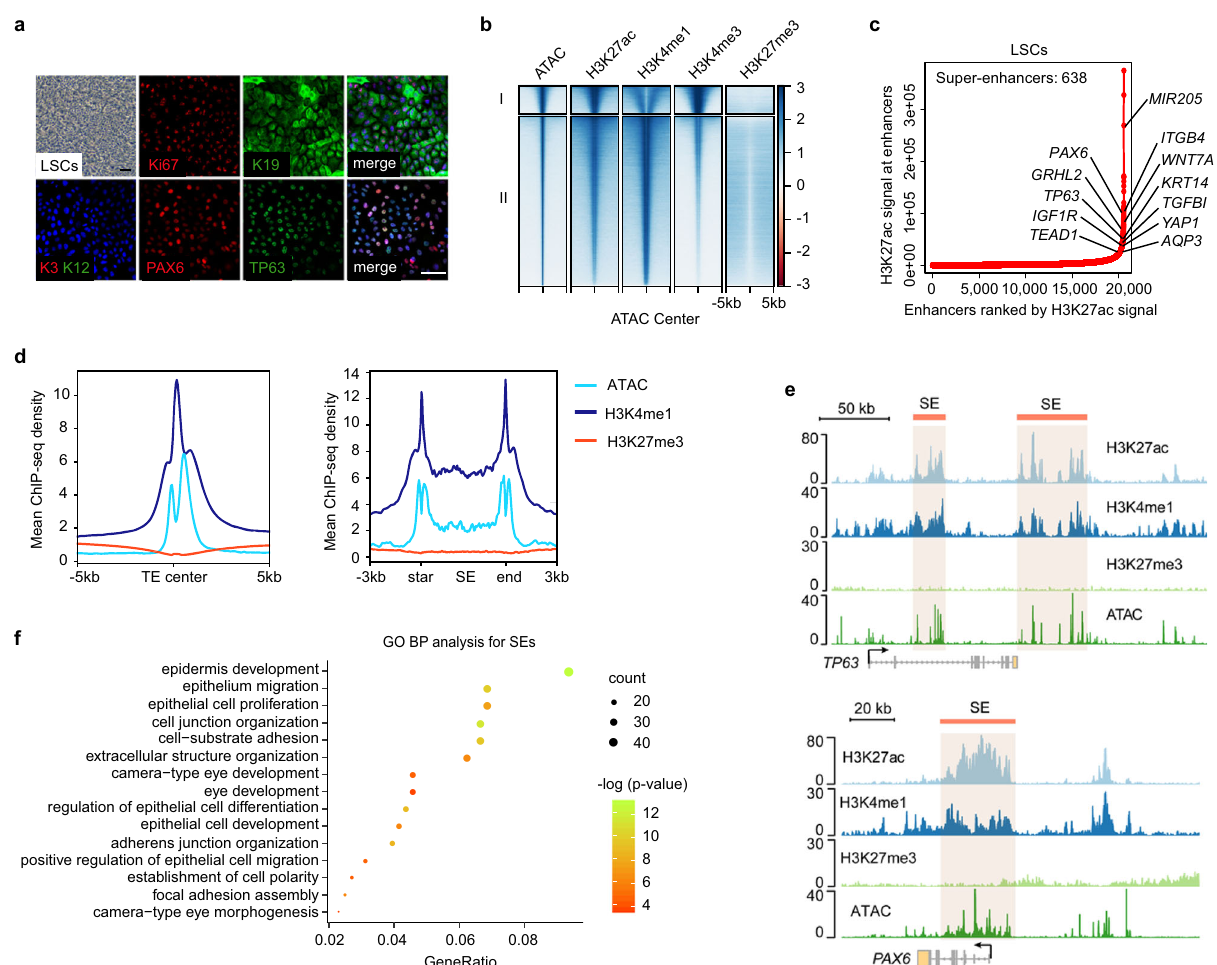
Fig. 1 Histone modi fi cation and chromatin accessibility landscapes of primary LSCs. a Phase contrast image and immuno fl uorescence staining of primary LSCs for the indicated marker genes. Scale bar, 100 μ m. b Heatmaps grouped into two clusters by k -means algorithm for ATAC-seq and the indicated ChIP- seq signals at the centers of ATAC peaks in LSCs. c Ranked enhancer plots de fi ned by H3K27ac. Enhancers above the in fl ection point of the curve have exceptionally strong H3K27ac signals and are de fi ned as SEs. The selected genes are SE-associated genes. d Metaplots of average ATAC-seq, H3K4me1, and H3K27me3 density at TEs (left) and SEs (right) in LSCs. e Genome browser tracks for H3K27ac, H3K4me1, H3K27me3, and ATAC-seq signals at the indicated SE loci. f GO biological process (BP) analysis of SE-associated genes with pvalueCutoff = 0.01 and qvalueCutoff =